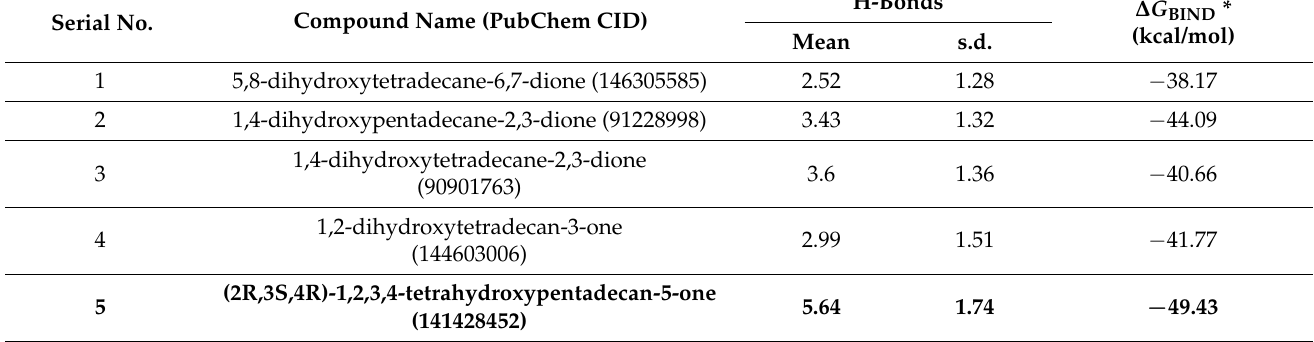
Table 2. Average number of intermolecular hydrogen bonds and ∆ G BIND of the five